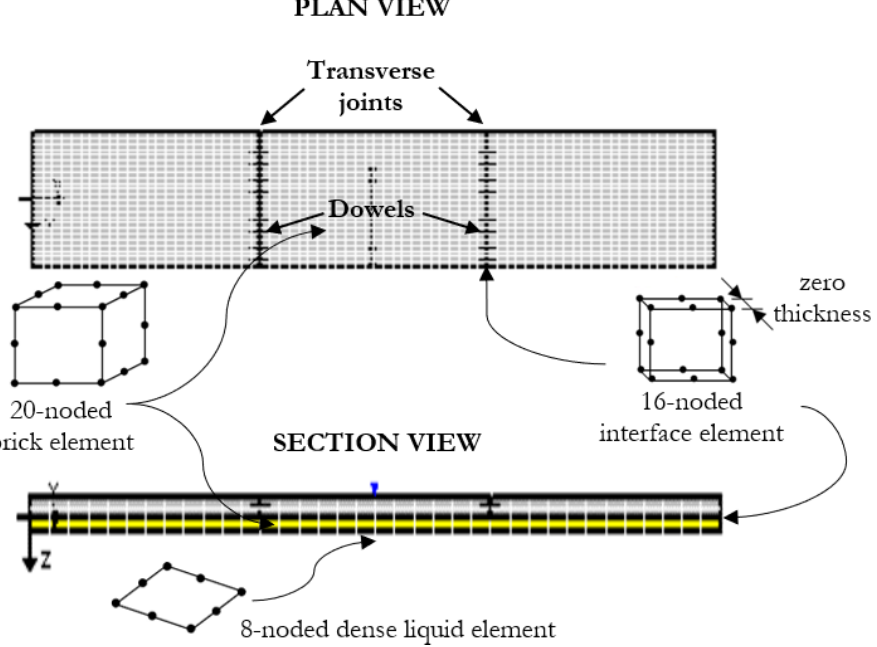
Figure 3. Finite elements used in the EverFE 2.25 discretization (Source: adapted from Davids et al. [14]).